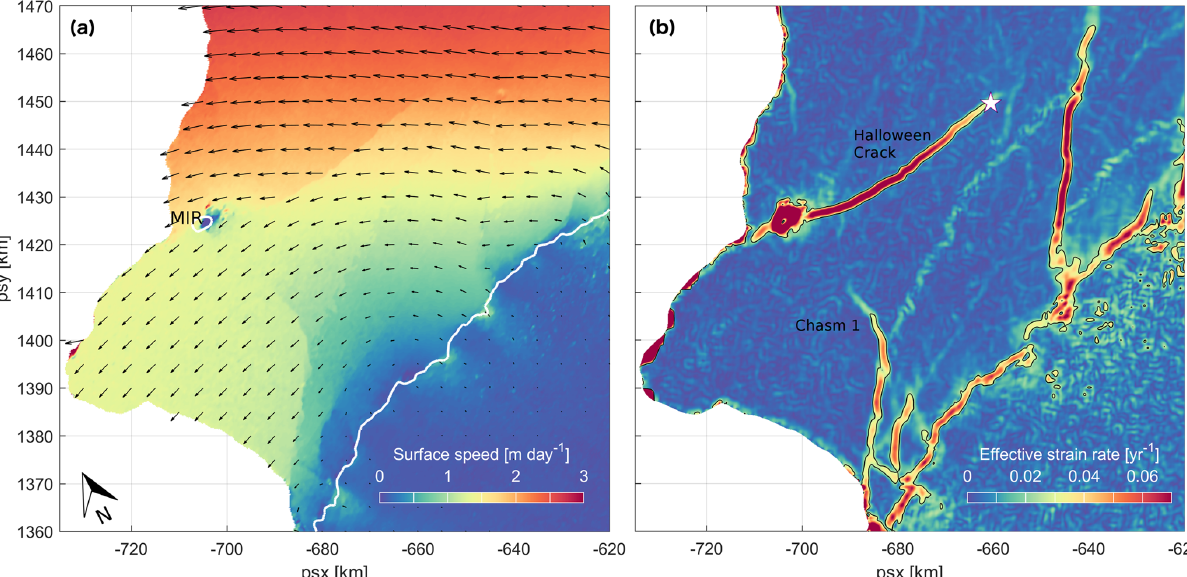
Figure 7. (a) Surface velocities subsampled onto a 4km by 4km regular grid (arrows) and speed (colours), obtained from a Sentinel-1 image pair (14 and 20 May 2017) using an iterative offset tracking method. (b) Effective strain rates derived from the velocity field in panel (a) using a quadratic regression method as detailed in the main text. The black line corresponds to the (cid:15) e = 0 . 025yr − 1 contour, and the white star indicates the easternmost extent of the HC as outlined by the